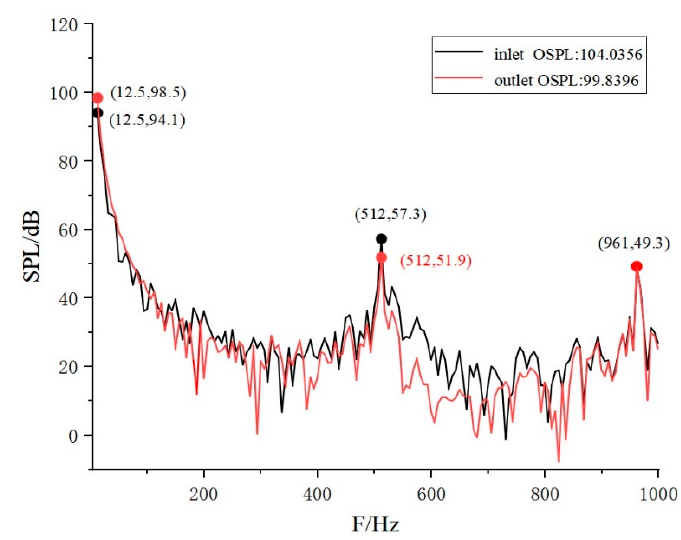
Figure 26. Spectrum diagram with 2.5 times flow area.